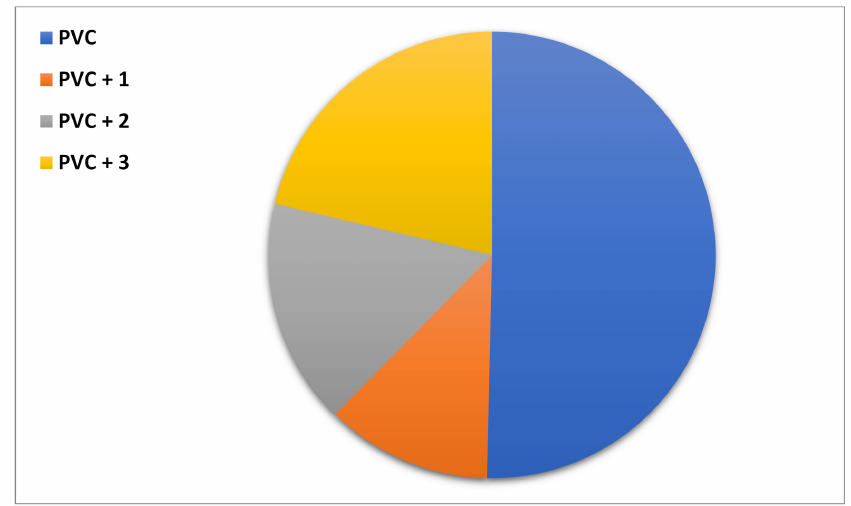
Figure 3. Changes in the I C=O upon thermal degradation.